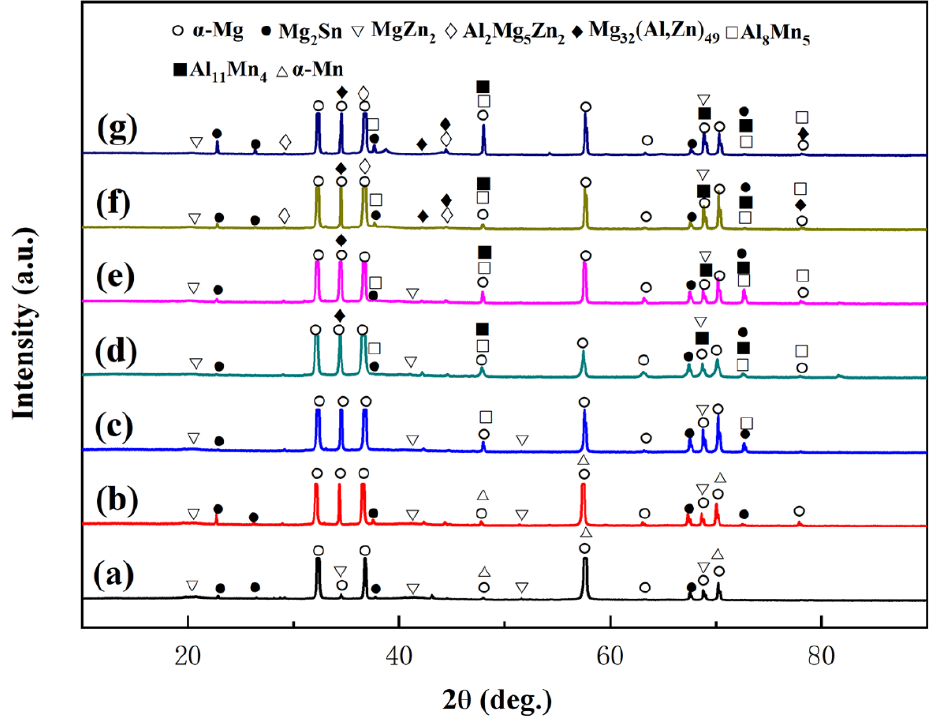
Figure 1. XRD patterns of the single-aged ZTM641-xAl alloys, ( a ) x = 0, ( b ) x = 0.2, ( c ) x = 0.5, ( d ) x = 1, ( e ) x = 2, ( f ) x = 3 and ( g ) x = 4.